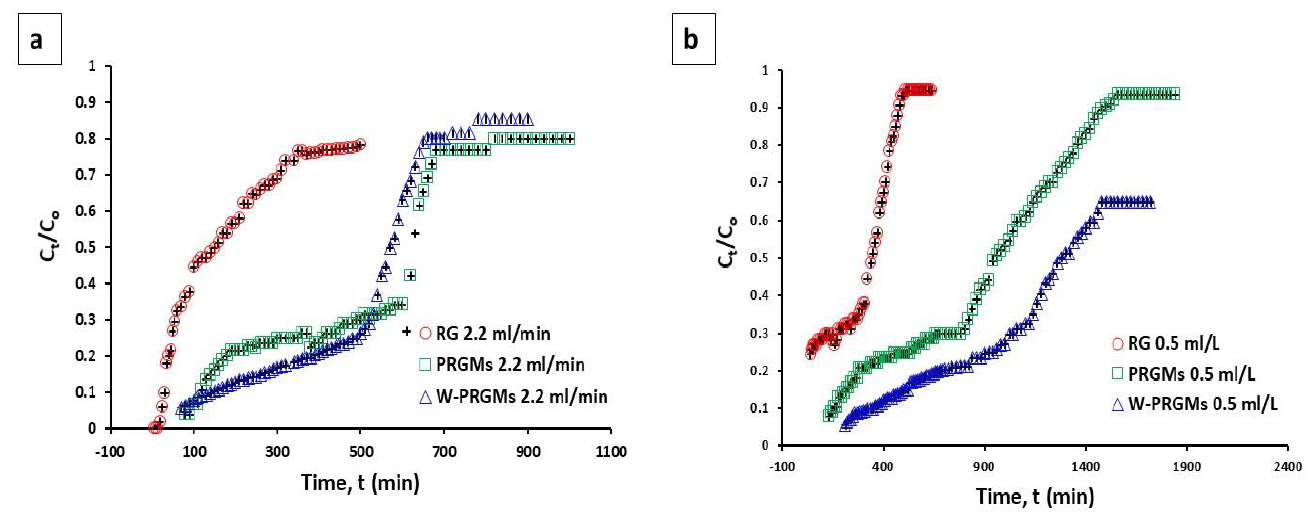
Figure 6. Breakthrough curve of AR88 dye adsorption for RG, PRGMs and W-PRGMs at ( a ) 2.2 mL/min and ( b ) 0.5 mL/min flow rates with starting dye concentration of 100 mg/L at 22 ± 2 °C. Table 3. The total adsorption and equilibrium adsorption capacity of AR88 at different flow rates for RG, PRGMs and W-PRGMs.